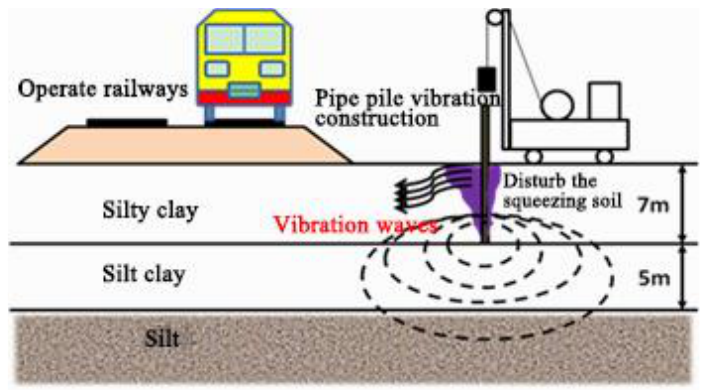
Figure 14. Piling influence